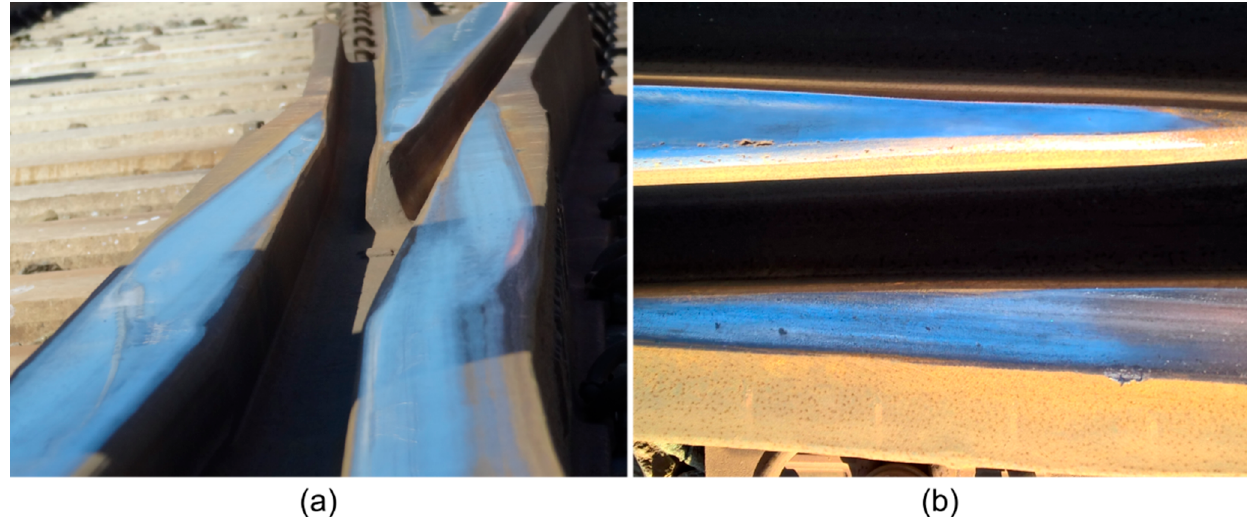
Figure 1. Degradation of railway crossing noses: ( a ) plastic deformation and wear of a manganese crossing nose and ( b ) material breakouts and spalling/pitting at the crossing nose surface.